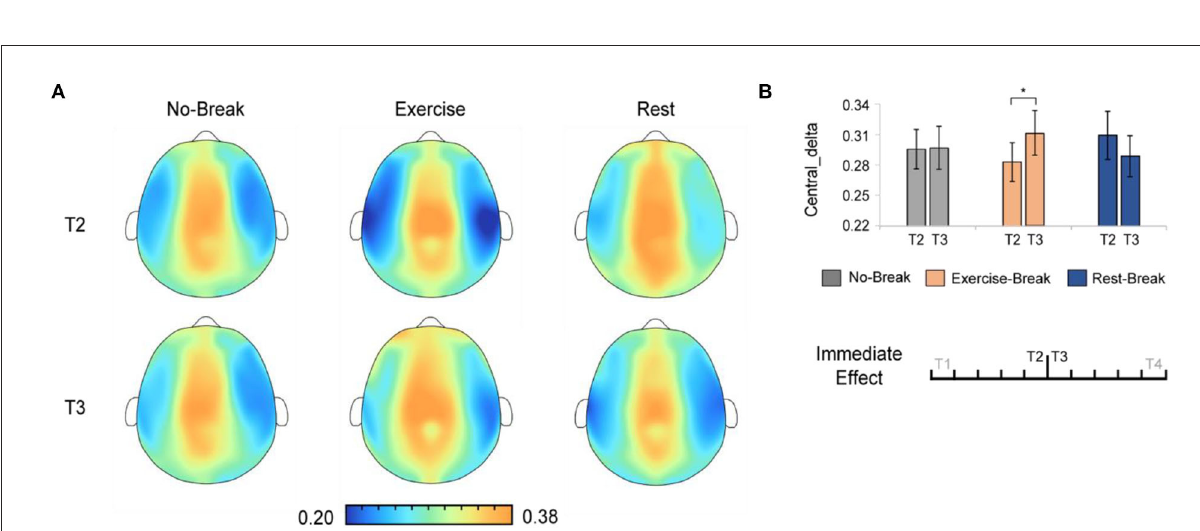
FIGURE5 The delta spectral changes in immediate effect (T2 vs. T3). (A) The brain topography of the immediate effect of the mid-task breaks on delta activities. (B) The EEG power ratios of the central delta in the pre-break bin (T2) and the post-break bin (T3). * p < 0.05. Error bars represent the mean ±